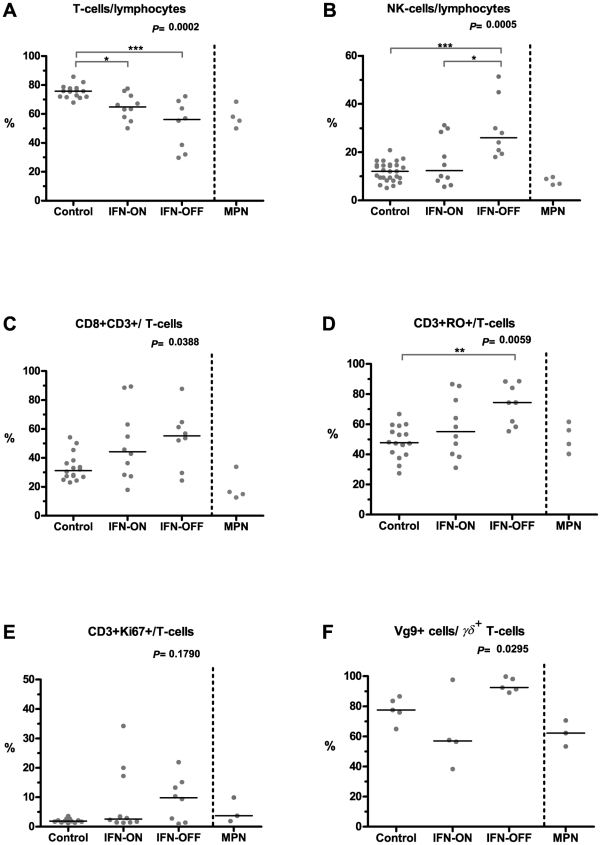
Flow cytometry analysis of basic lymphocyte subpopulations.Immunophenotyping was done with 6-color flow cytometry from healthy controls (n = 16), IFN-α-treated CML patients (IFN-ON, n = 10), and CML patients who had discontinued IFN-α therapy (IFN-OFF, n = 9). Figures represent relative proportions of analyzed cells and corresponding absolute numbers can be found in Table S1. Statistical significance of differences in continuous variables was assessed by a non-parametric analysis of variance using the Kruskal-Wallis test (P-values reported in figures) and in case of a significant main effect, pairwise comparisons of patient groups were calculated using Dunn's multiple comparison test (statistically significant differences between groups are marked with asterisks and line). For the analysis of Vγ9+ cells (panel F), samples from 5 healthy controls, 4 IFN-ON, and 5 IFN-OFF patients were available. The figures also include results from four patients with myeloproliferative neoplasm (MPN), but they were not included in the statistical analysis.